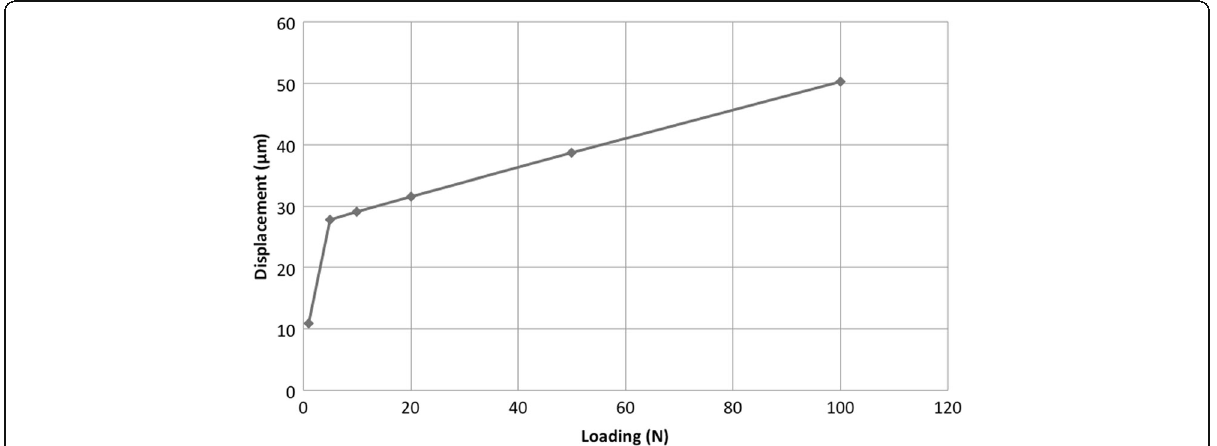
Fig. 3 Load displacement curves of natural teeth in FE